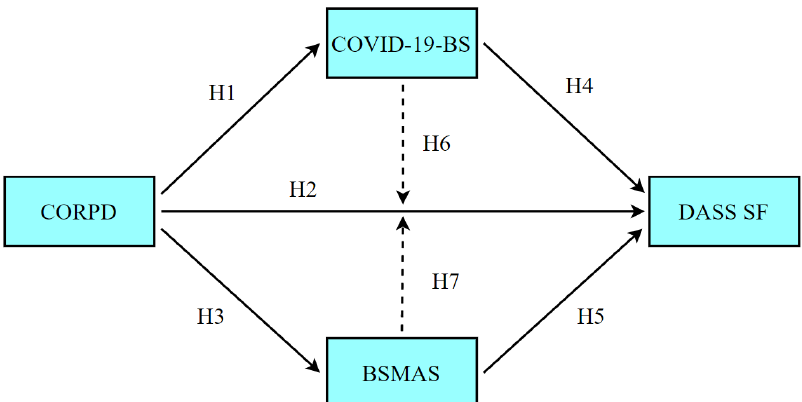
Figure 1. Hypothesized relationships of the research model (CORPD = COVID-19–Related Psychological Distress; COVID-19-BS = COVID-19 Burnout; BSMAS = Social Media Addiction; DASS SF = Depression).